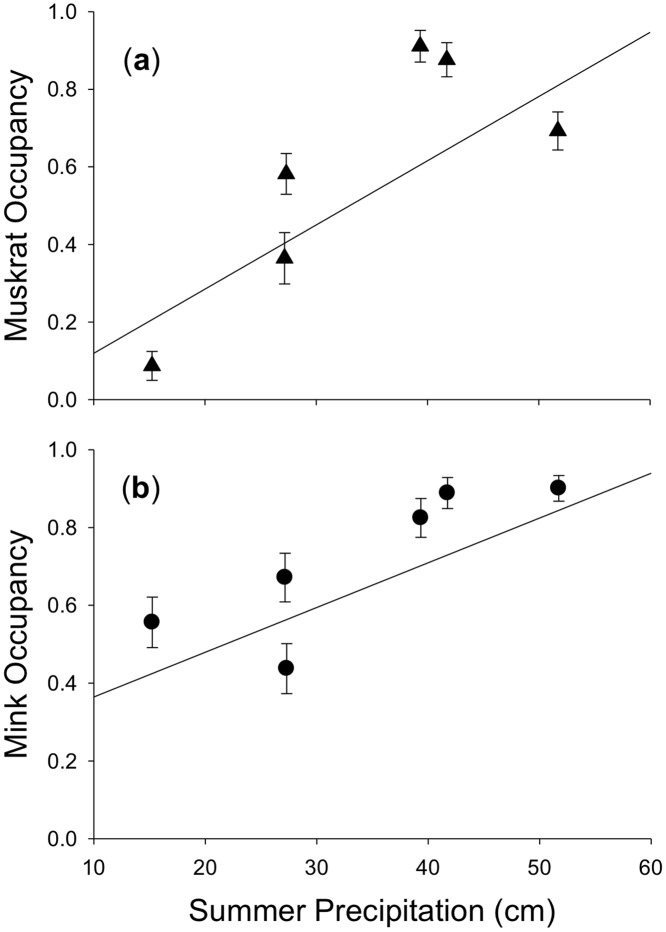
Relationship between site occupancy by (a) muskrat, and (b) mink and 3-month precipitation (May, June, and July) from 2007–2012 in Illinois, USA.Estimates of site occupancy (± 1 SE) are model-averaged and corrected for imperfect detection.